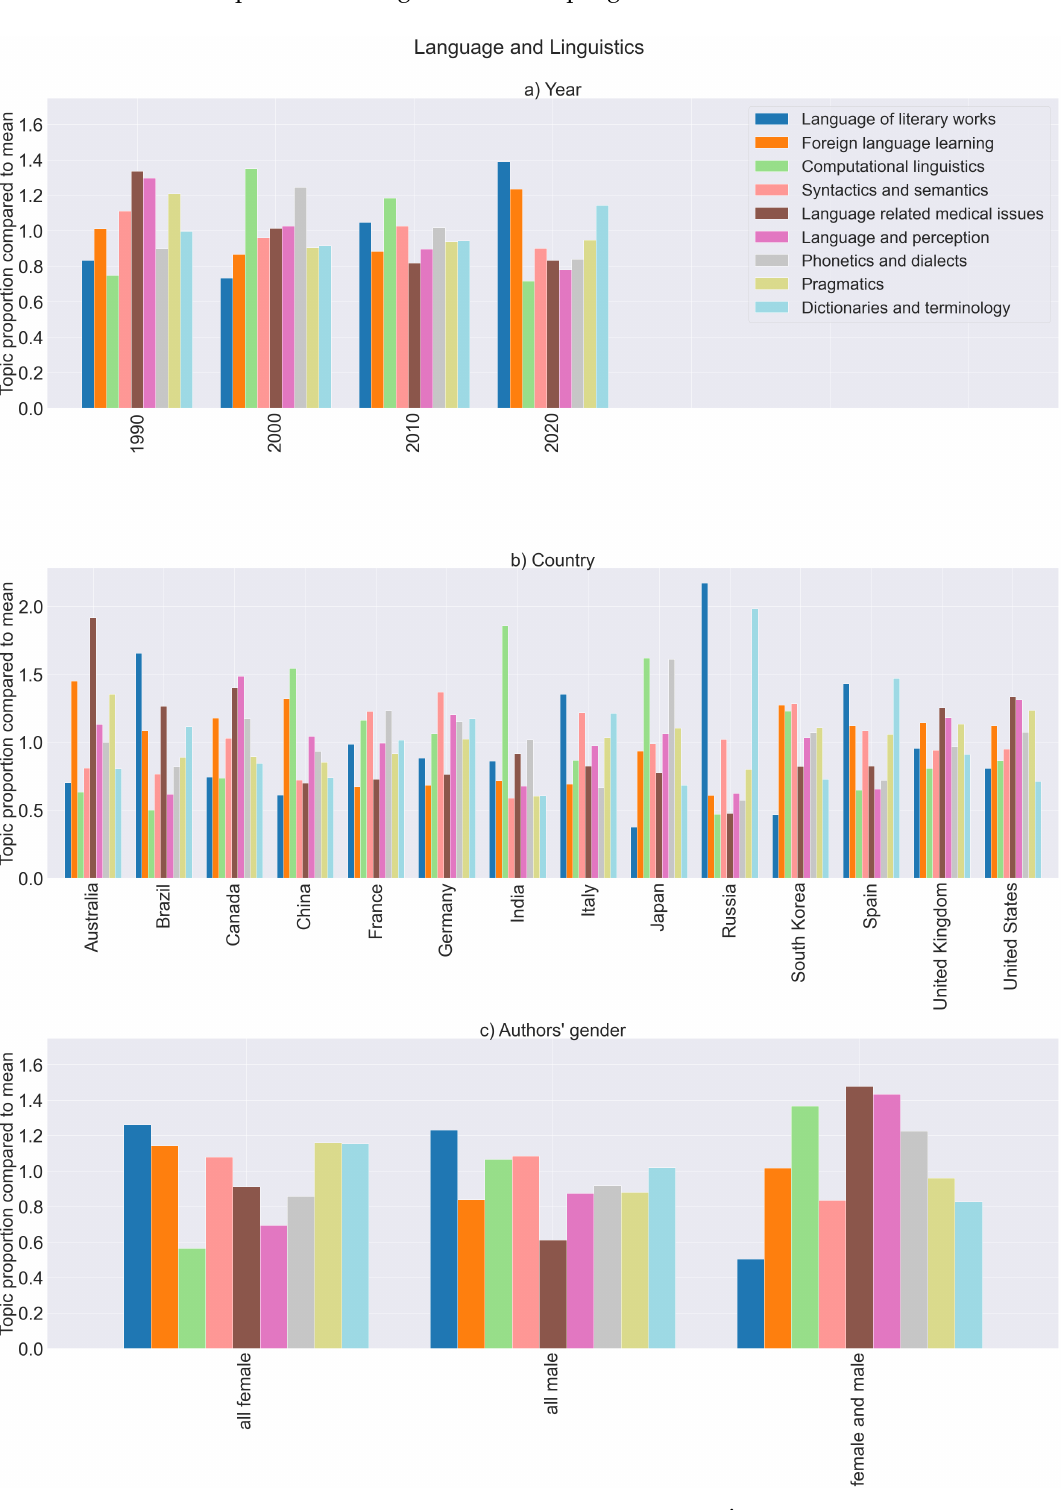
Figure 4. Topic proportion compared to mean, c κ ( ˆ D α ) , for 9 topics of the sub-area language and linguistics grouped by ( a ) publication year, ( b ) country, and ( c ) authors’ gender. The legend for the topics and their colour codes at the top right corner applies to all three